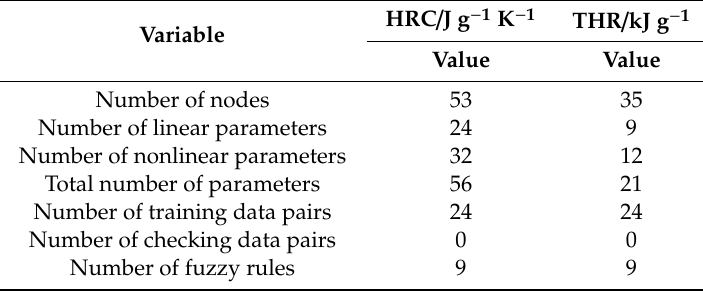
Table 7. Specifications for ANFIS